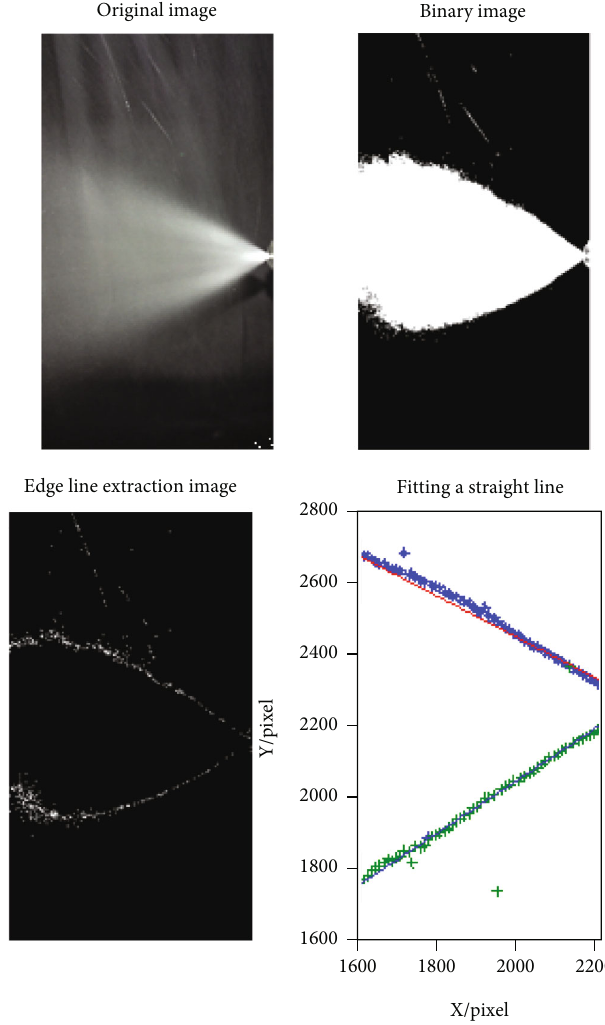
Figure 2: Extraction process of atomization angle.